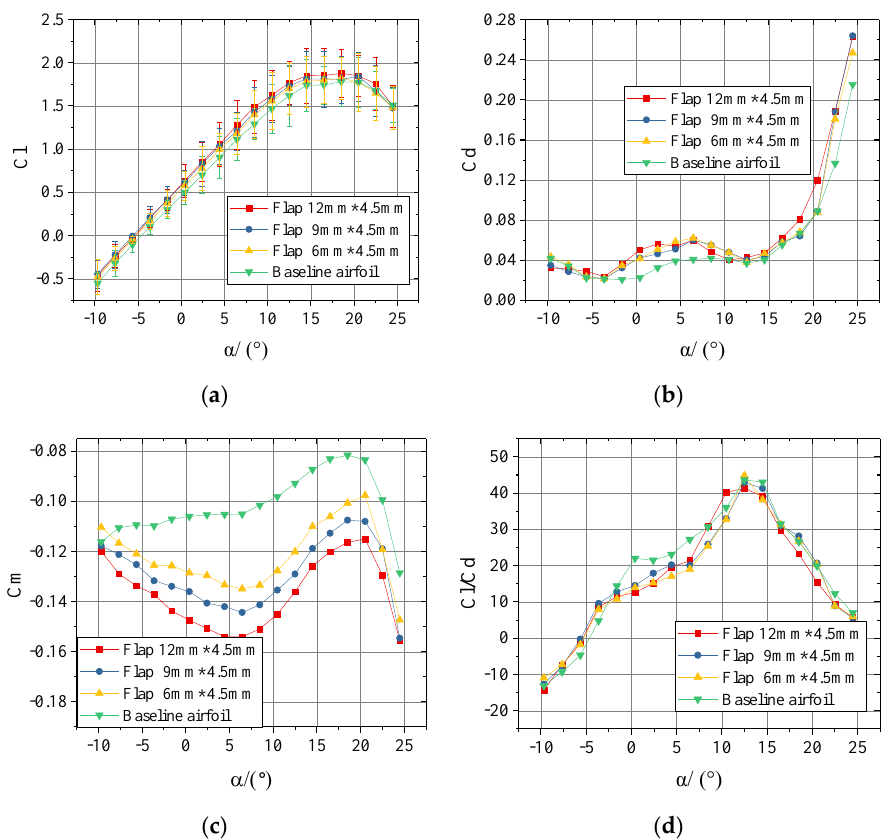
Figure 14. Variation of the aerodynamic characteristics with different heights of Gurney flaps (T.I. of 19%, Re: 0.8 × 10 6 ). ( a ) Lift coefficient comparison; ( b ) drag coefficient comparison; ( c ) pitching-moment coefficient comparison; ( d ) lift-to-drag ratio comparison.